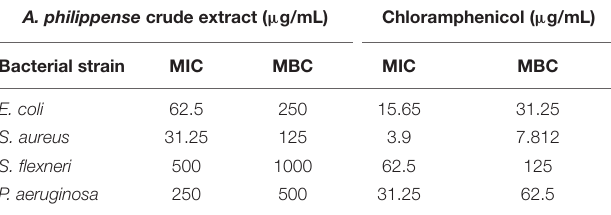
TABLE 2 | Antibacterial activity of A. philippense crude extract.